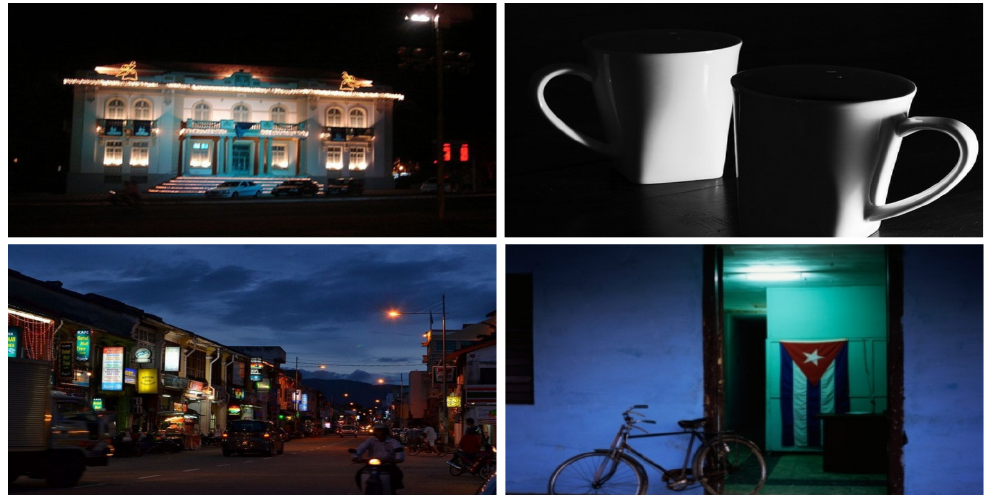
Figure 4. Samples taken from ExDARK dataset. The dataset has images captured in low light and indoor scenes.